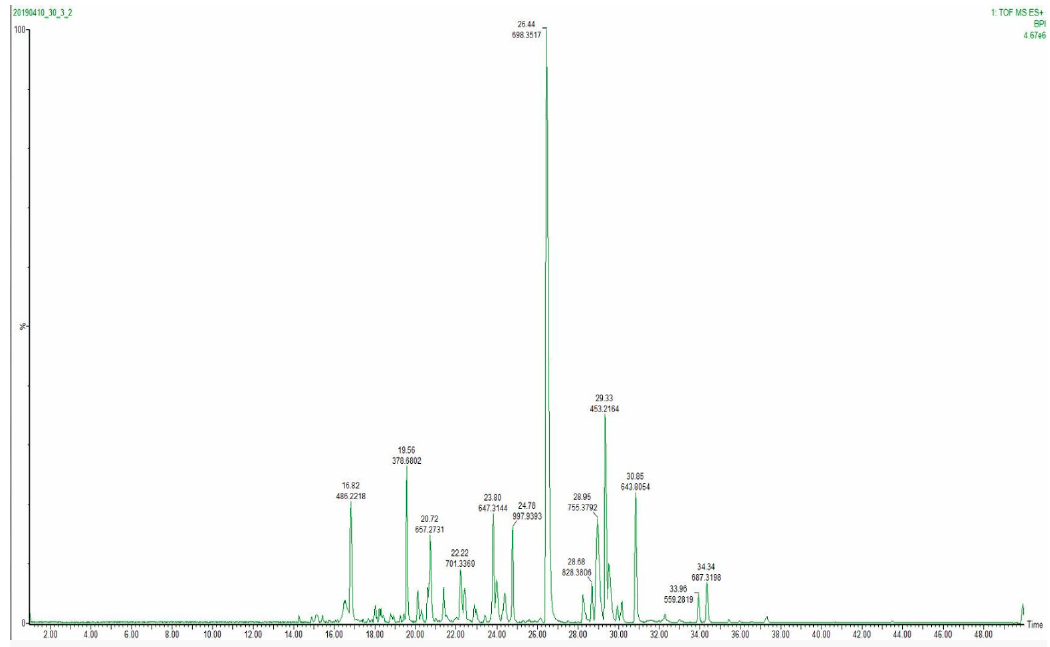
Figure 7. Base peak intensity (BPI) chromatogram of 40 min analytical gradient.